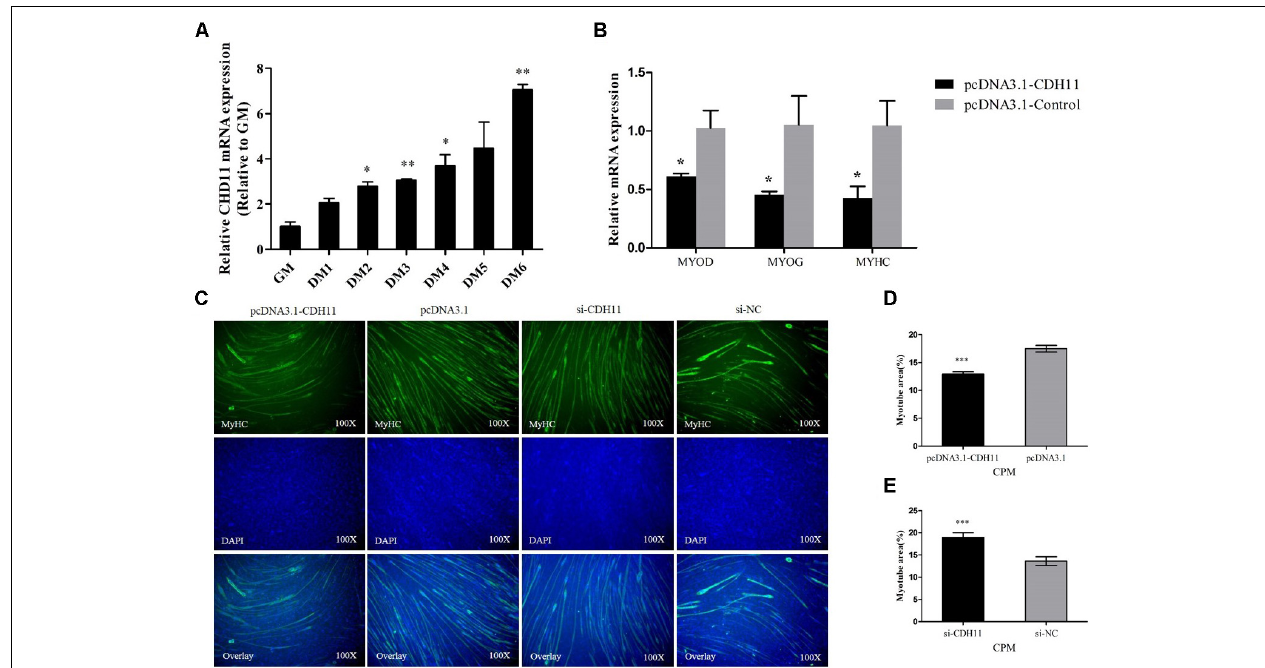
FIGURE 2 | CDH11 is an inhibitor of myoblast differentiation. (A) The relative mRNA level of CDH11 during CPM cells differentiation. GM representing myoblasts were in proliferative phase, while DM1......DM6 means myoblasts were successfully induced to differentiate from day 1 to day 6. (B) The mRNA levels of myoblast differentiation marker genes were detected after transfected with pcDNA3.1-CDH11. (C) MyHC staining of CPM cells at 72 h after transfected with pcDNA3.1-CDH11 and si-CDH11. (D,E) Myotube area (%) of CPM cells with CDH11 overexpression and knockdown. Results are shown as mean ± SEM and the data are representative of at least three independent assays. Independent sample t -test was used to analyze the statistical differences between groups. ∗ P < 0.05; ∗∗ P < 0.01; ∗∗∗ P < 0.001.